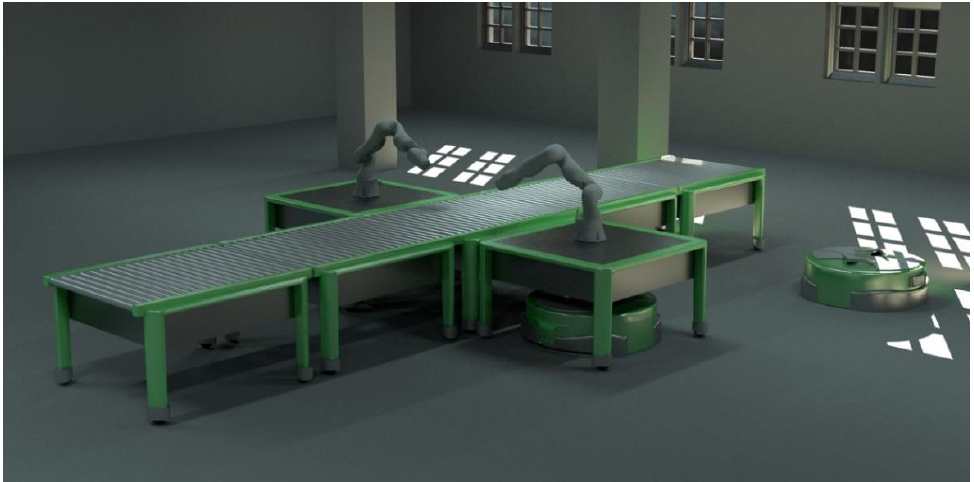
Figure 3. An artistic vision of our application.